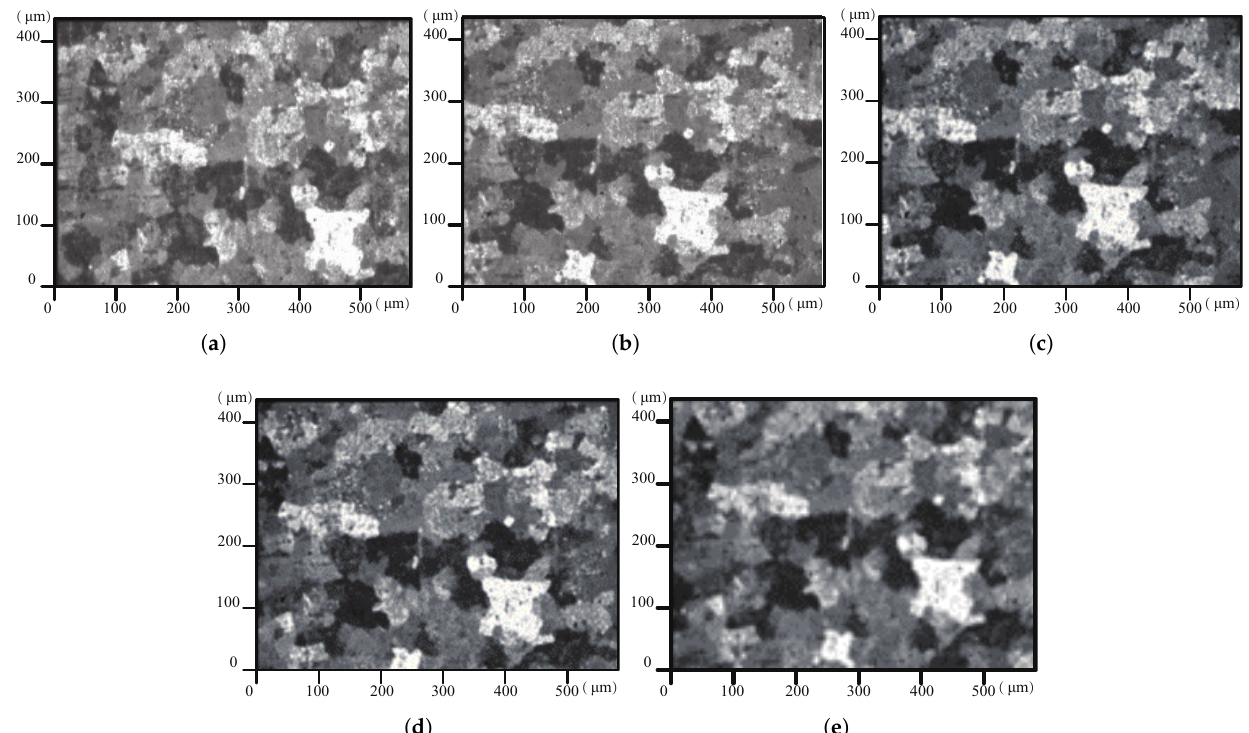
Figure 3. The original grain image of pure aluminum plate sample: ( a ) GRAB 1; ( b ) GRAB 5; ( c ) GRAB 10; ( d ) GRAB 14; ( e ) GRAB 15.